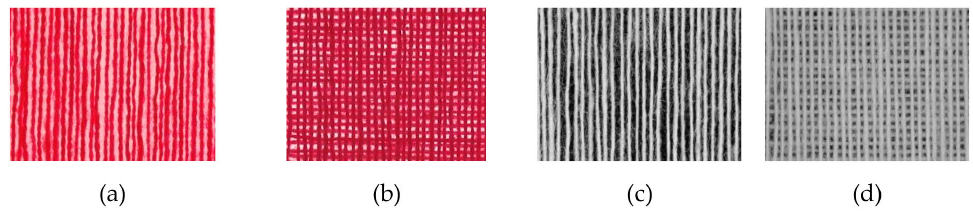
Figure 6. Single-layered ( a , c ) double-layered yarn systems ( b , d ) from colored cotton (CO) yarns ( a , b ) and undyed polyester (PET) yarns ( c , d ) in 10× magnification.